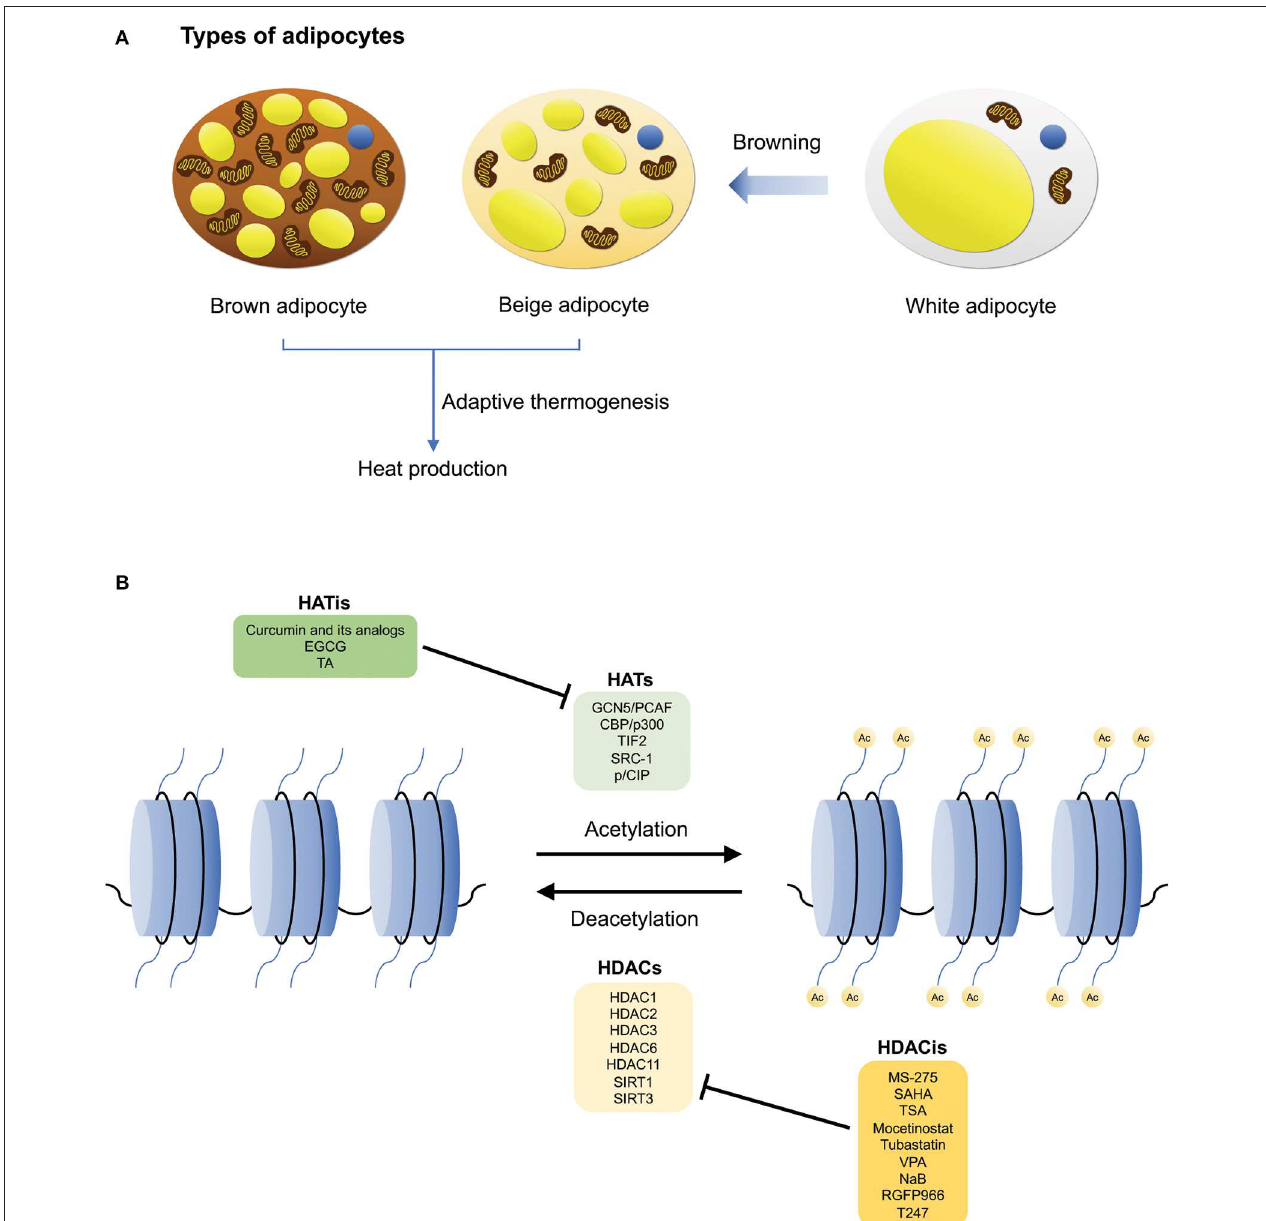
FIGURE 1 | The different types of adipocytes, and HATs/HDACs that regulate brown adipogenesis and adaptive thermogenesis. (A) The three main types of adipocytes: white, brown, and beige adipocytes. White adipocytes are involved in energy storage, while brown adipocytes are involved in adaptive thermogenesis during which heat is produced. Brown adipocytes also consist of a high mitochondrial content and UCP1 expression. Beige adipocytes are derived from white adipocyte precursor cells and similar to brown adipocytes, they can undergo adaptive thermogenesis upon stimulation, through a process known as browning. (B) Histone acetylation and deacetylation are mediated by HATs and HDACs, respectively. Examples of HATs/HDACs and their inhibitors that are involved in regulating thermogenic adipocyte differentiation, adaptive thermogenesis, and the pathogenesis of metabolic disorders.